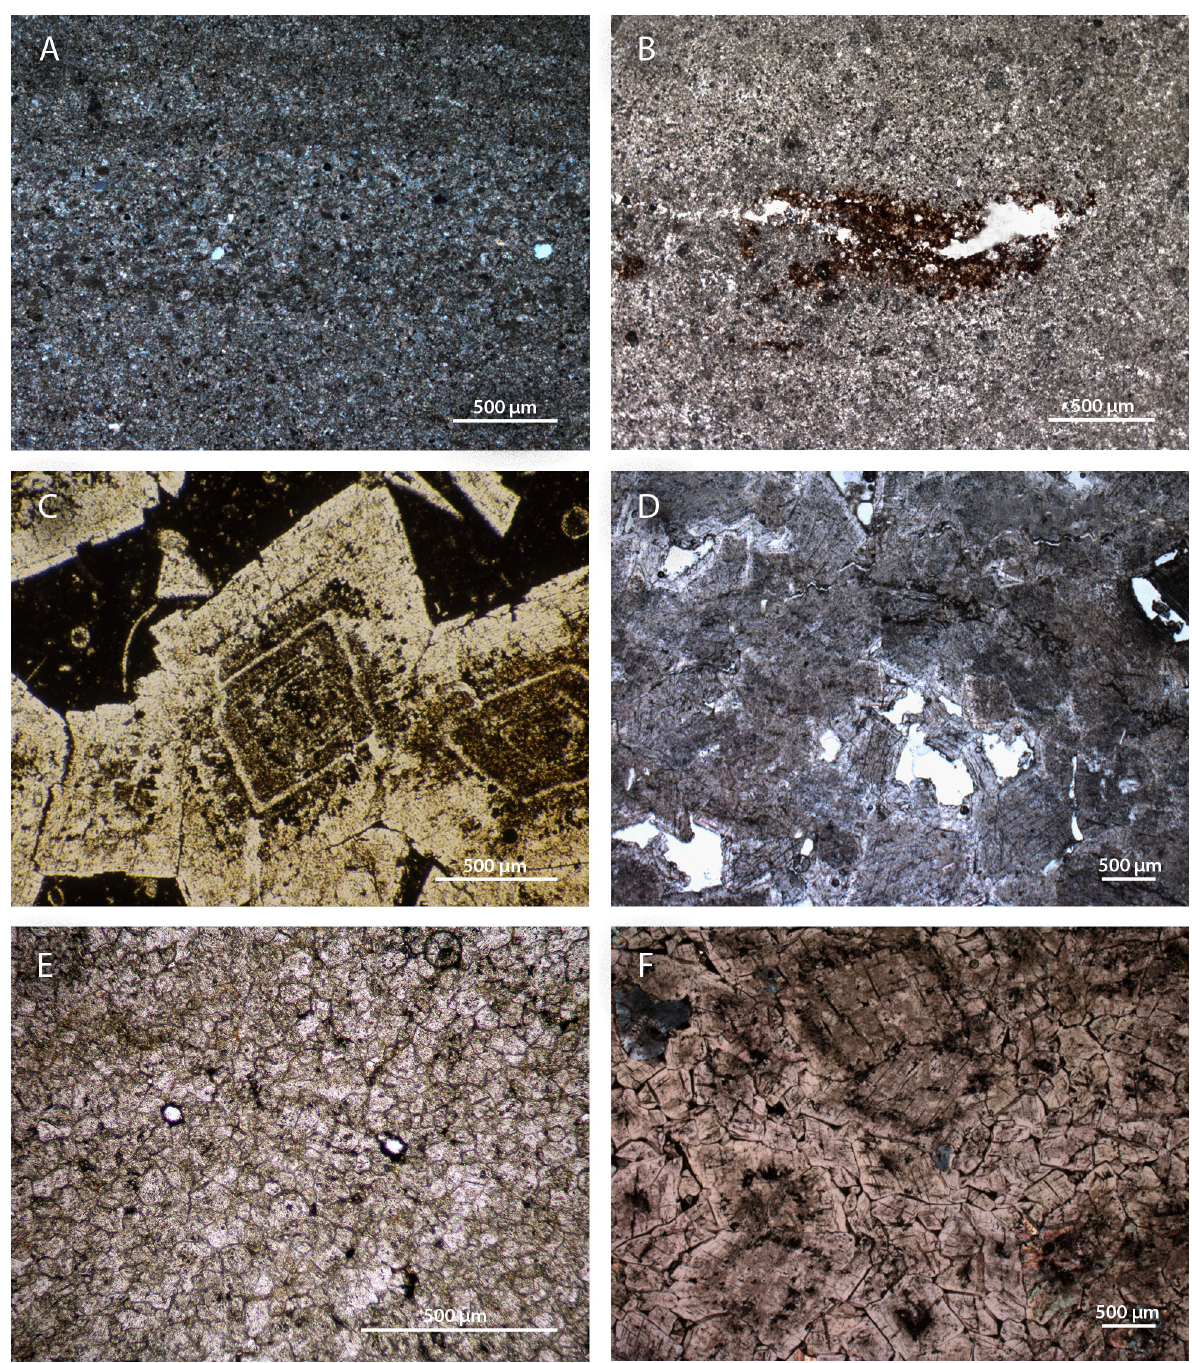
Fig. 6. Thin section photomicrographs in cross-polarized light illustrating different types of dolomite crystals present in the studied rocks. ( A ) Type 1 dolomite, Snetnaya Gora Fm, Ape drill core, 16.6 m, GIT 442-602. ( B ) Type 2 dolomite, Upper Pskov unit, Ape drill core, 3.8 m, GIT 442-500. ( C ) Type 3 dolomite, Upper Pskov unit, Hino drill core, 45.8 m, GIT 441-637. ( D ) Type 4 dolomite, Upper Pskov unit, Ape drill core, 1.4 m, GIT 442-585. ( E ) Type 5 dolomite, Lower Pskov unit, Tsiistre drill core, 52.9 m, GIT 550-4. ( F ) Type 6 dolomite, Lower Pskov unit, Hino drill core, 53.0 m, GIT